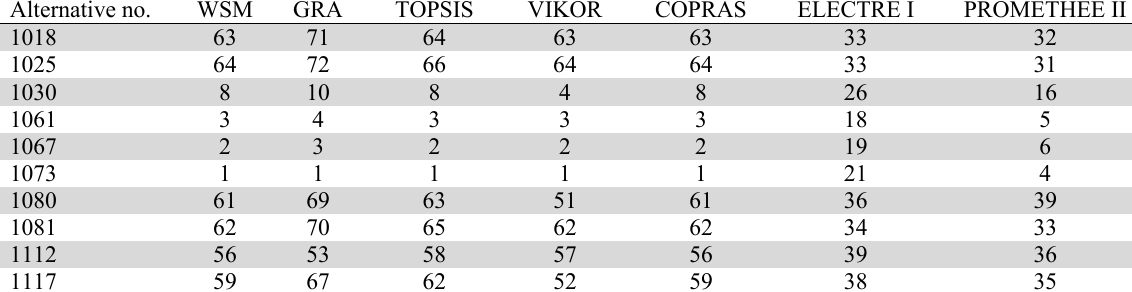
Ranking of alternatives obtained from seven decision making techniques Alternative no.